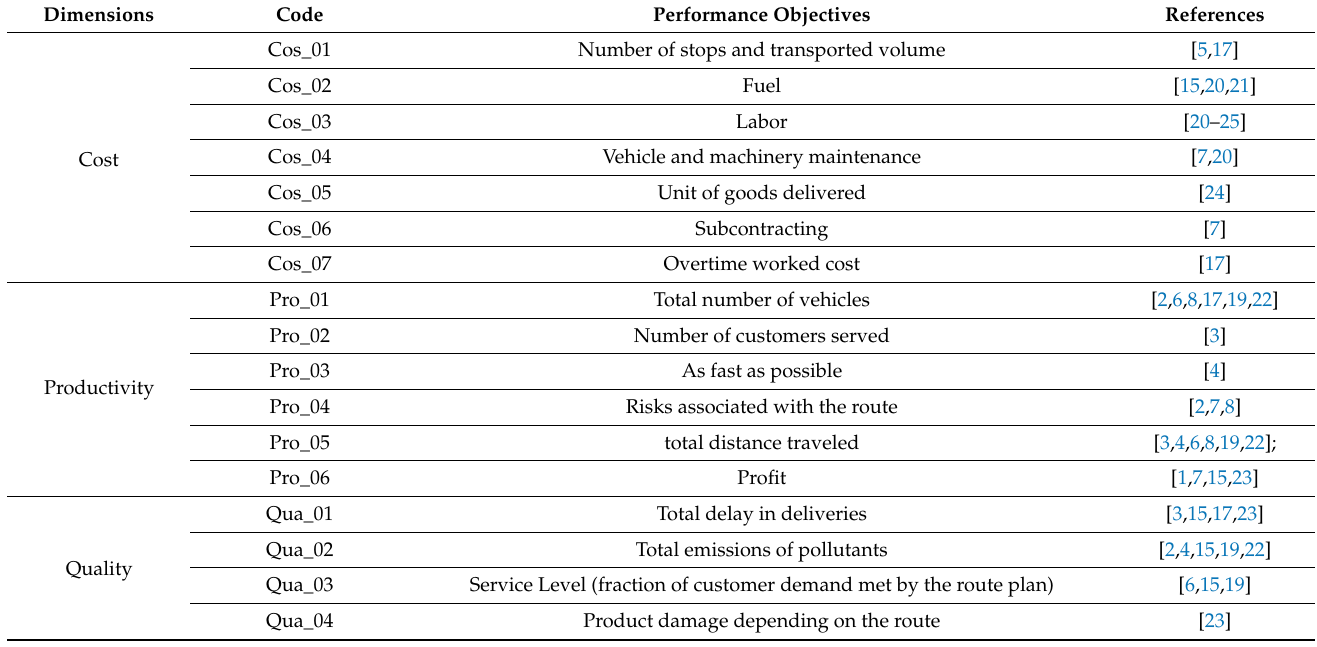
Table 1. Performance objectives have been identified in the